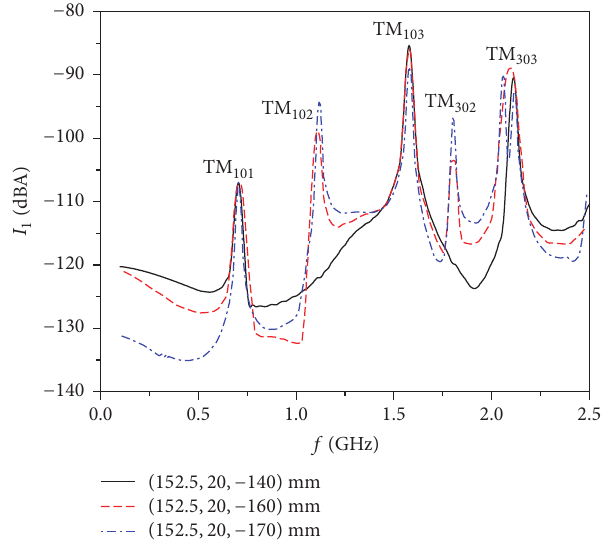
Figure 7: Electric current induced at termination load 𝑍 1 for the electric dipole of different positions.